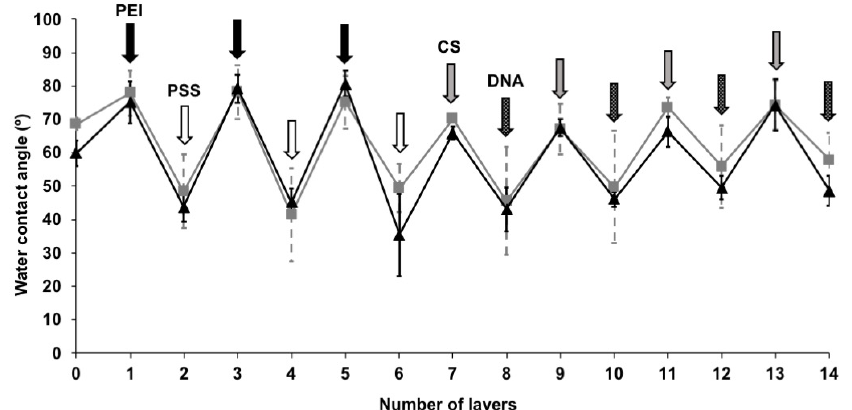
Figure 3. Water contact angles of (PEI-PSS) 3 followed by (CS-DNA) 4 multilayer films on PMMA (grey line) and Ti (black line) surfaces. The error bars represent the standard deviation over three replicate surfaces and three measurements per surface.